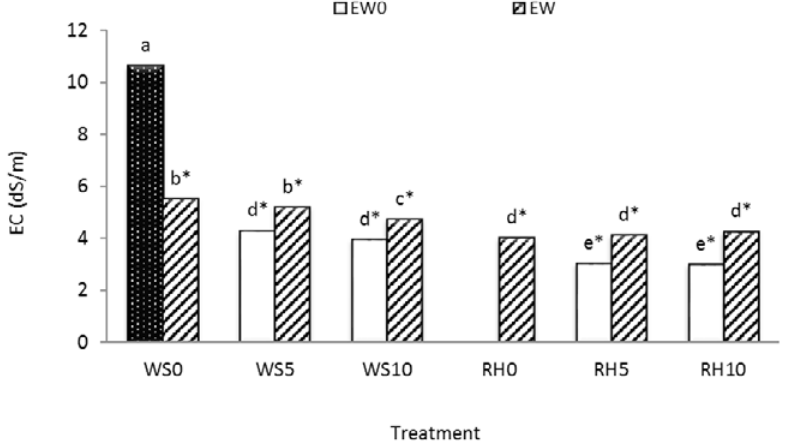
Figure 3. Effects of the treatments on wastewater EC EW0: without vermicomposting; EW: with vermicomposting; WS0: without wheat straw; WS5: 5% v/v wheat straw; WS10: 10% v/v wheat straw; RH0: without rice husk; RH5: 5% v/v rice husk; RH10: 10% v/v rice husk. Means in the same column followed by the same letter are not significantly different according to DMRT at (P≤0.05).